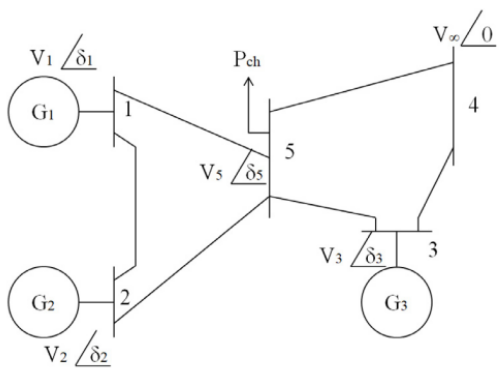
Figure 1. Three machine infinite